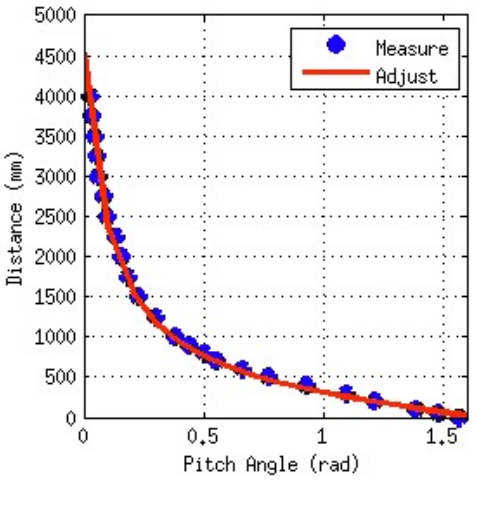
Figure 11. Example of polynomial adjustment (based on empirical measures) that establishes the relationship between head angles and distance-to-features centered in an